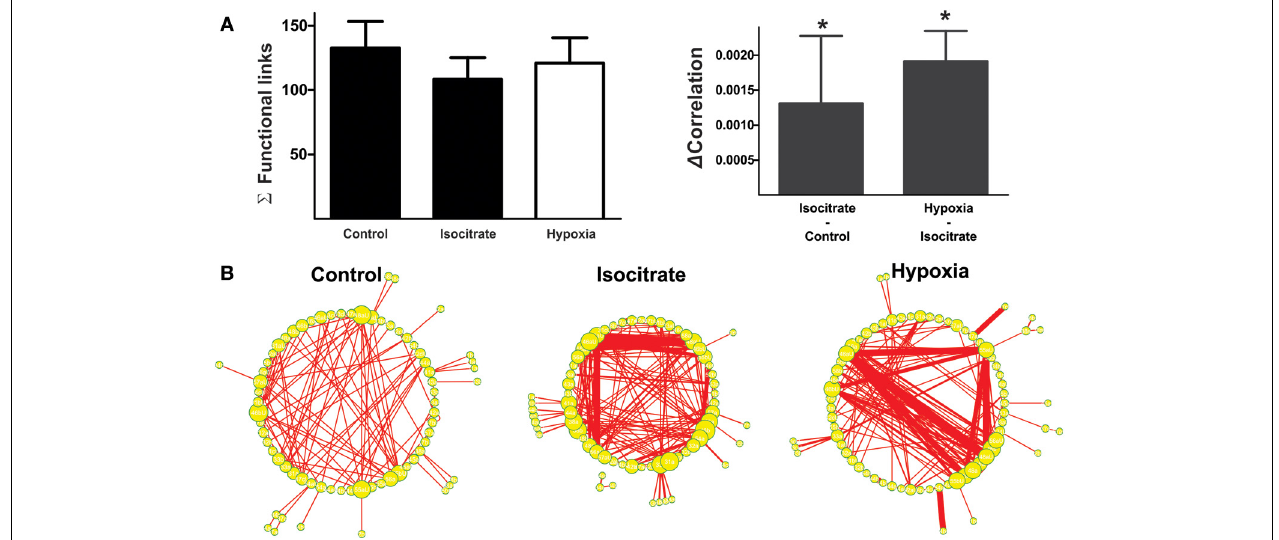
in normoxia before and after isocitrate application and in hypoxic conditions in the presence of isocitrate. Each respiratory element is represented as a circle and each significant correlation between two elements is represented as a connecting line (functional link). The diameter of the circles is proportional to the number of functional links that each element has with other elements in the network. The width of the lines is proportional to the correlation value of any given link. Note that isocitrate increases the strength of the functional links but does not significantly change their number. When hypoxia is applied in the presence of isocitrate, the strength of the functional links increases even further, but again, their number remains